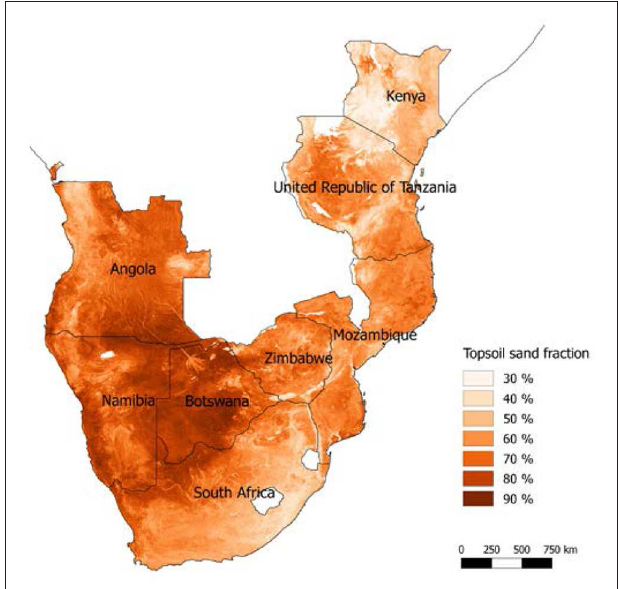
FIGURE 1 | The topsoil (0–5cm) sand fractions in six Southern African and two East African countries ( Hengl et al.,